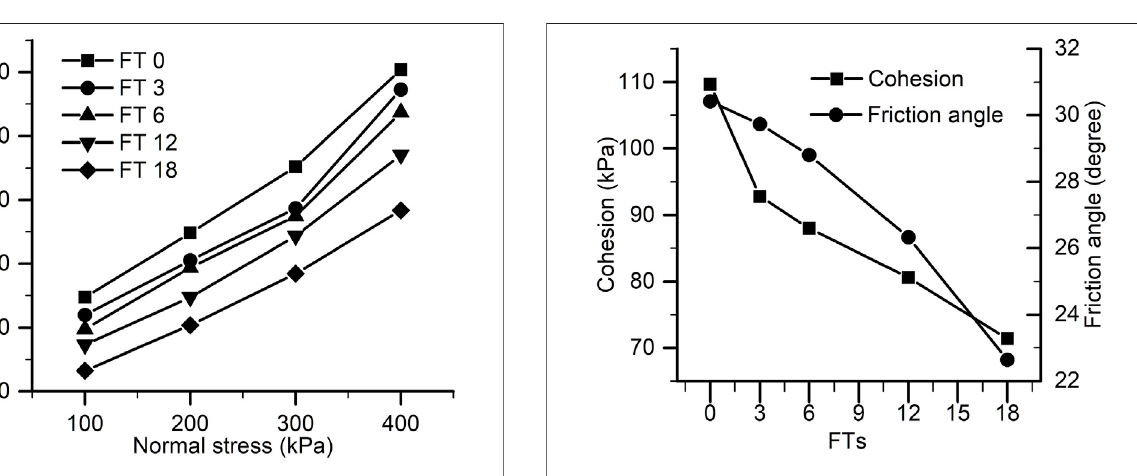
FIGURE 5 | Shear strengths of S/S sediments in FTs. FIGURE 6 | Constitutive parameters of S/S sediments in